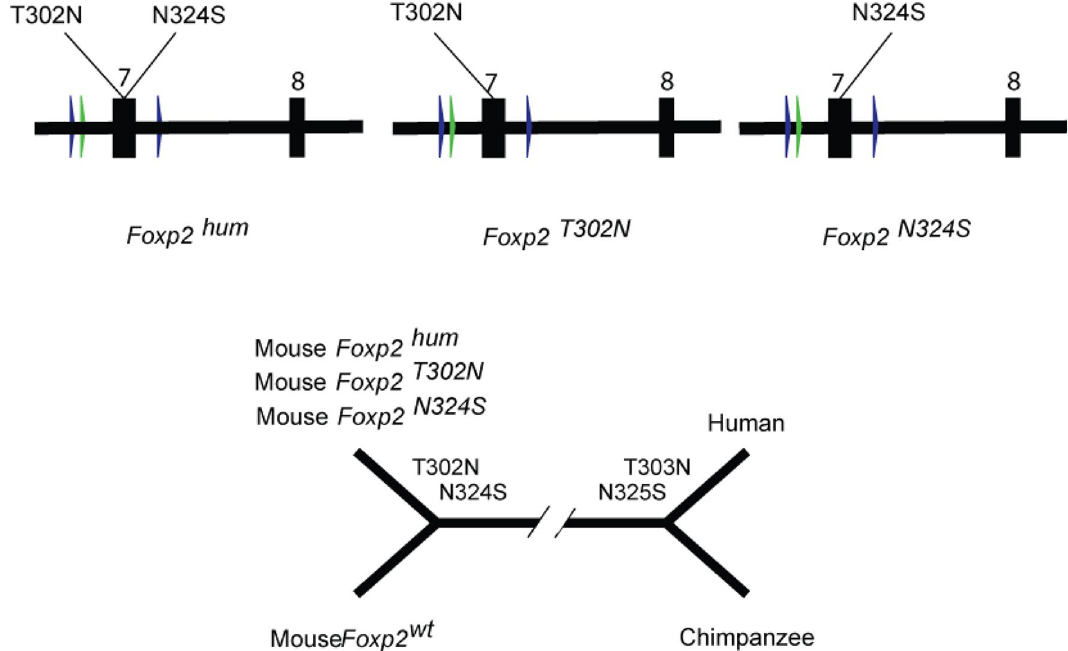
Figure 1. Overview of experimental setup. Blue arrows: loxP sites; green arrow: remaining FRT